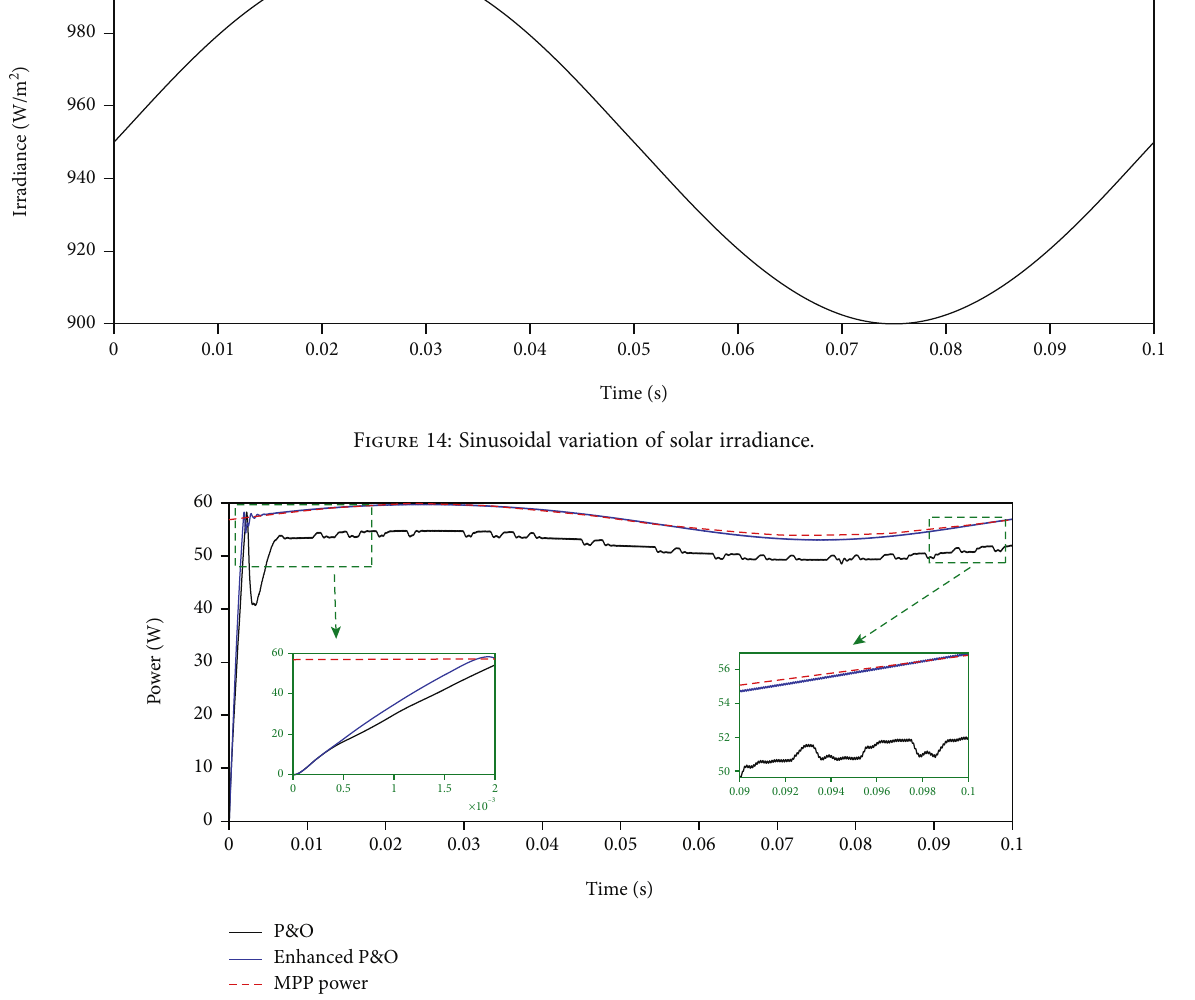
Figure 15: Tracking of MPP power with P&O, ideal MPPT, and enhanced P&O MPPT method under Test 2.